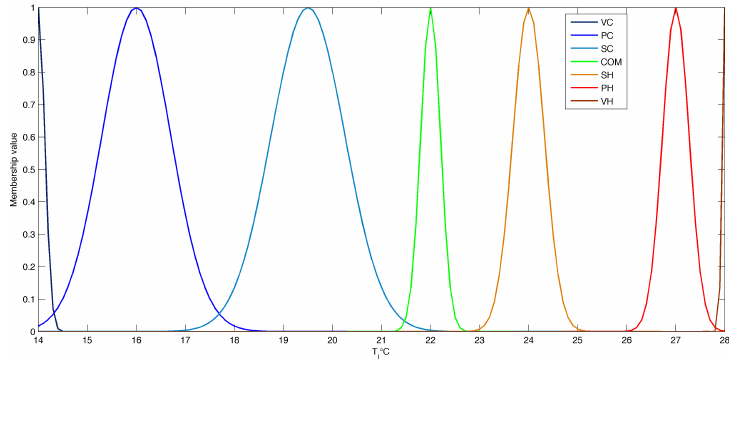
in the winter i